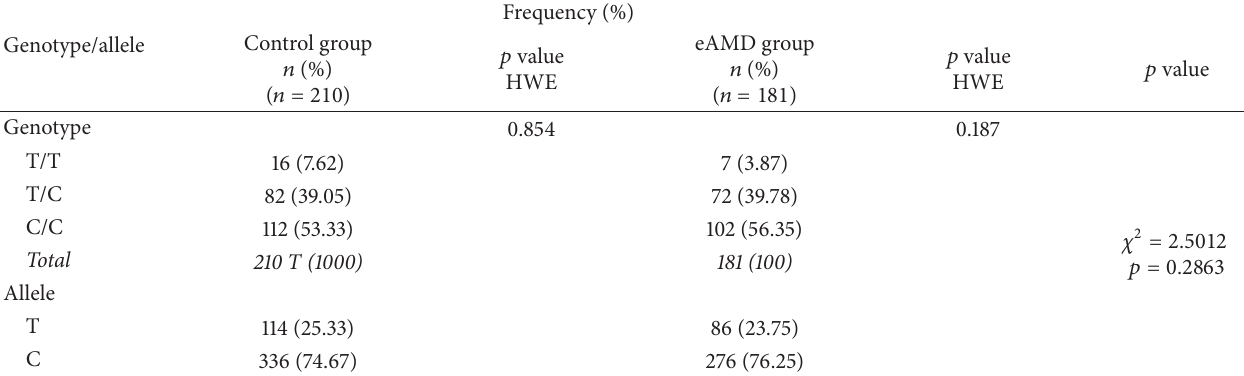
Table 3: Frequency of the CYP4F2 rs2108622 genotypes in the patients with eAMD and in the control group.